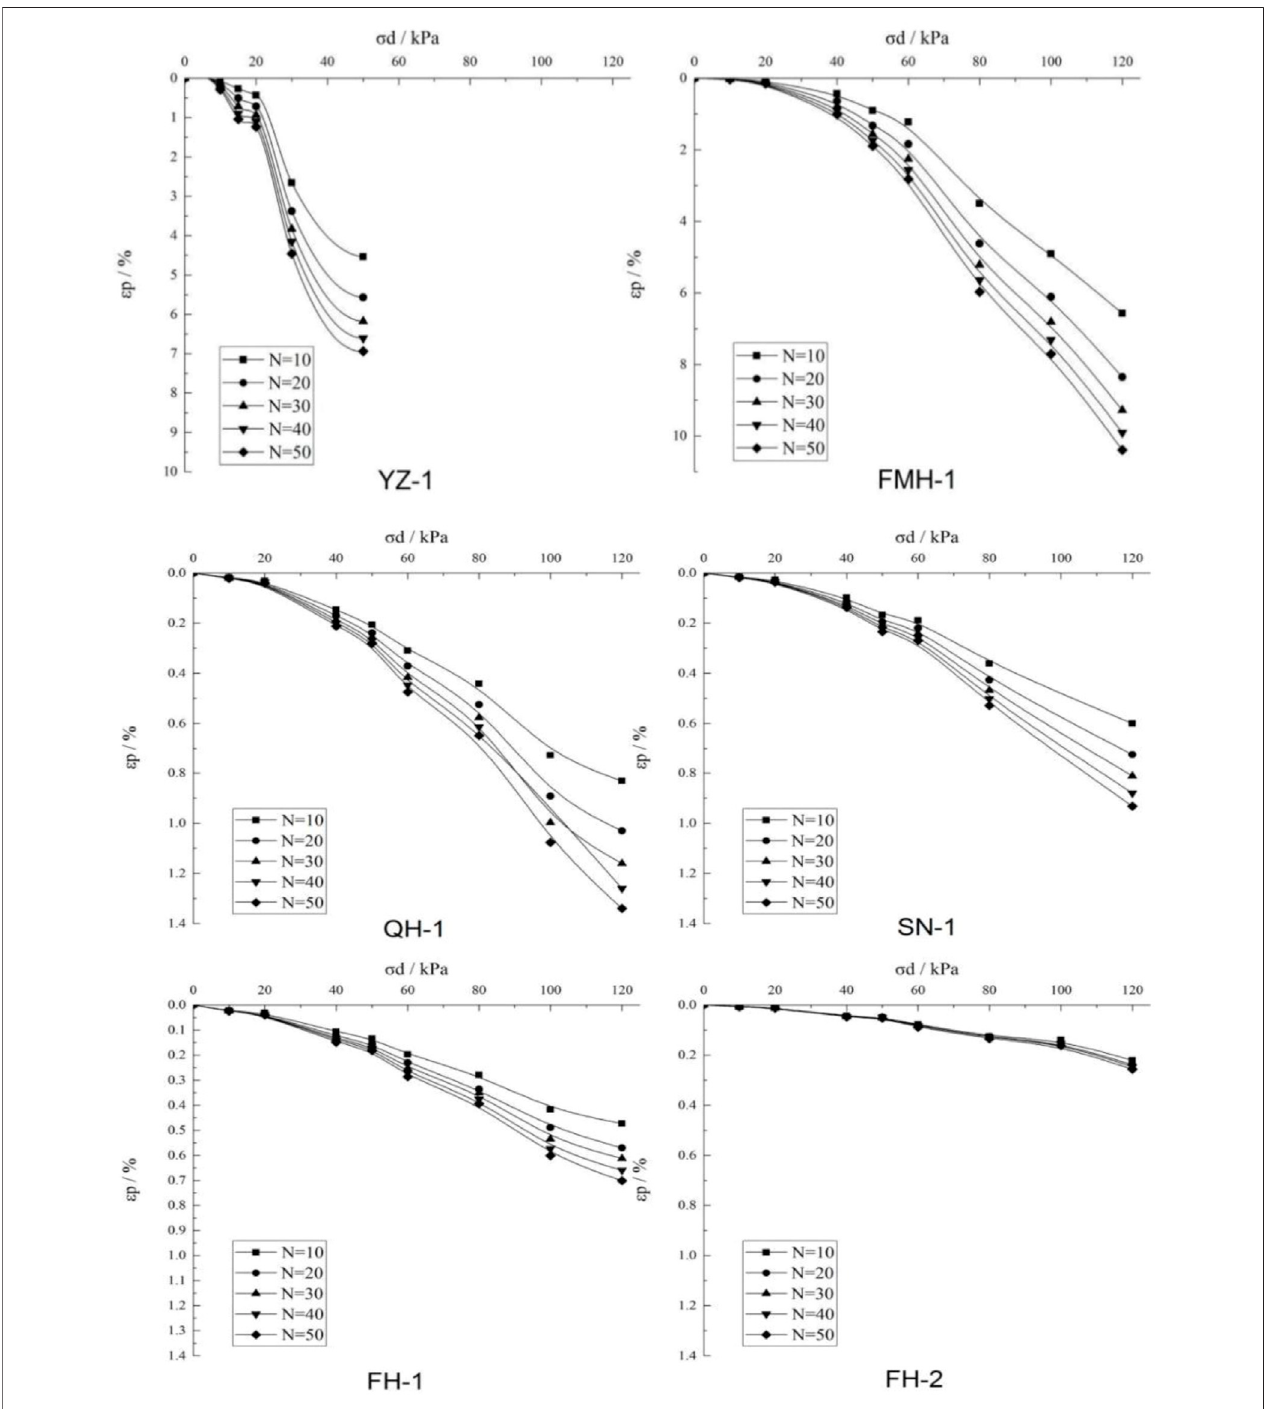
FIGURE 5 | Seismic subsidence coef fi cients of original and improved loess samples under different vibration times.